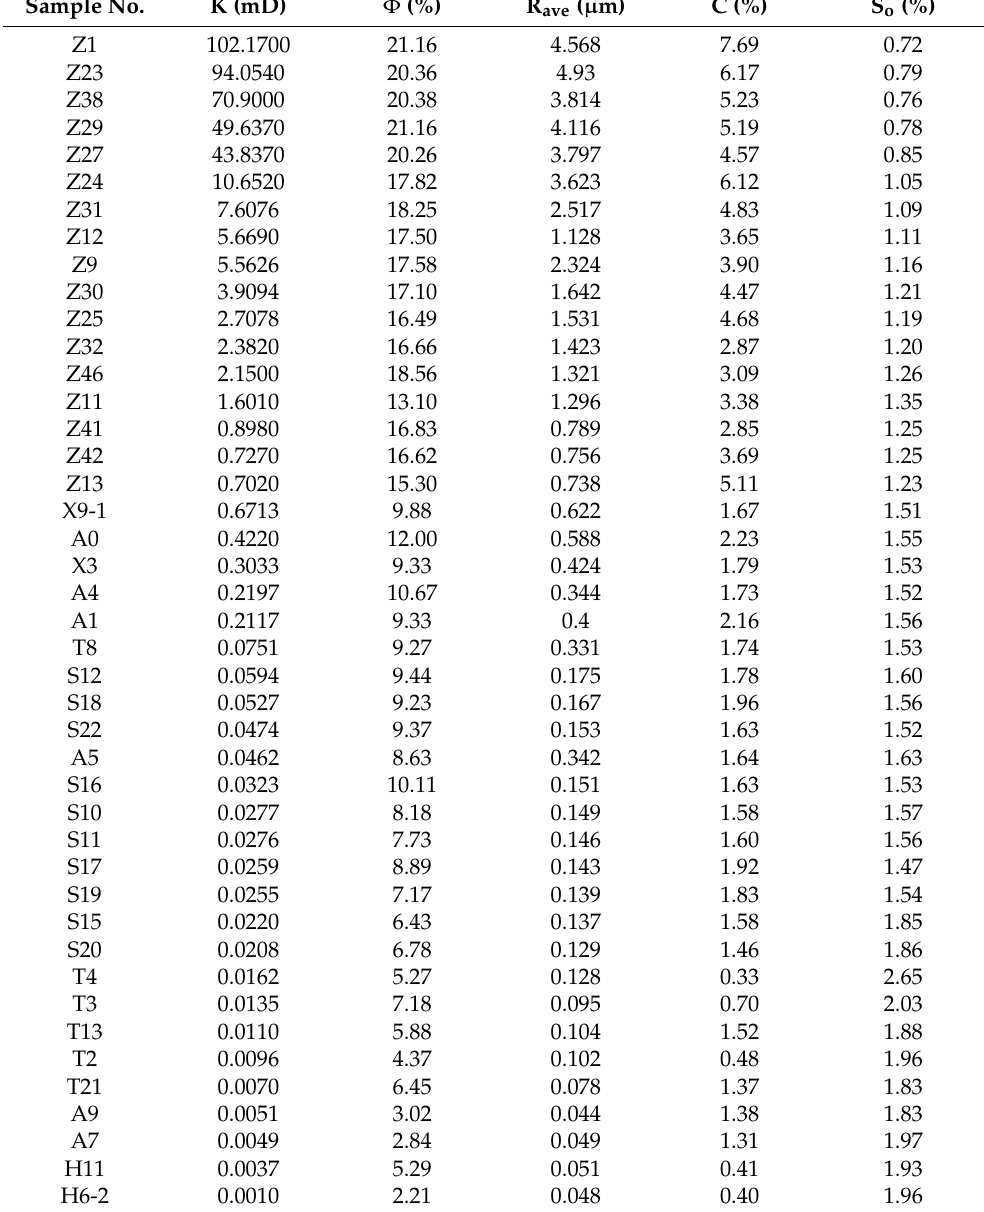
Table A1. The five indicators (PPACS) for the classification and evaluation of deep-mine sand-stone. Sample No.